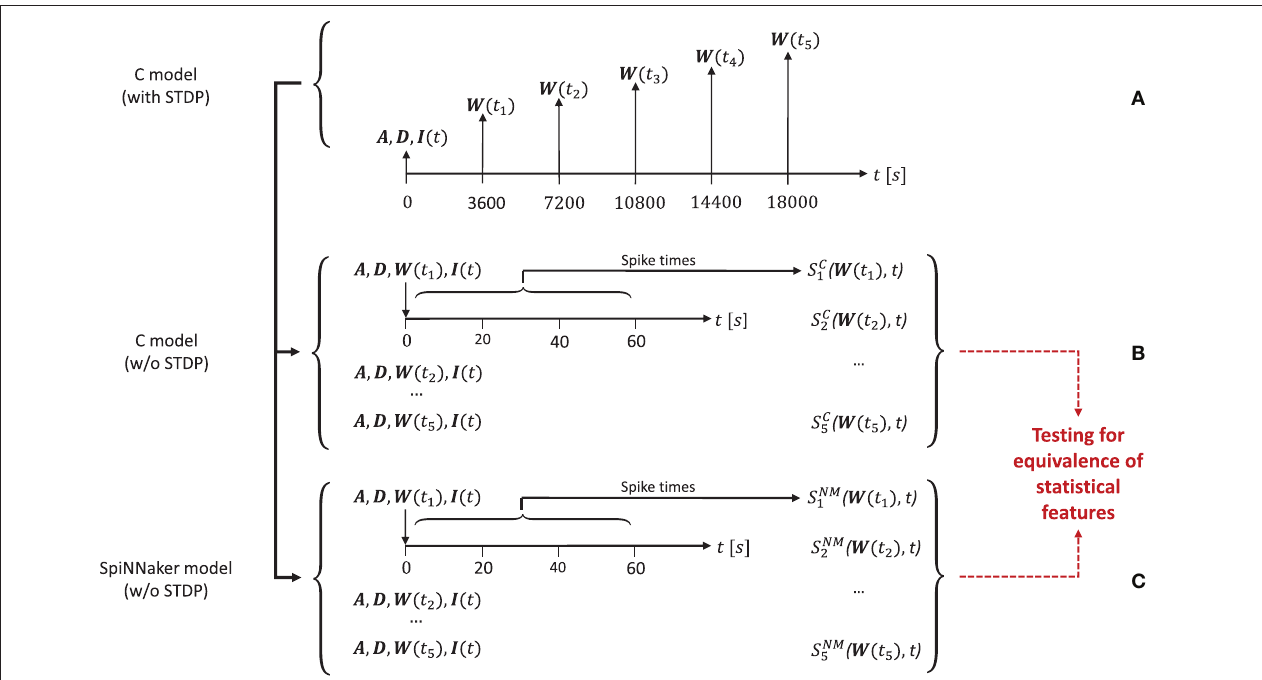
FIGURE 4 | Design of the simulation setup. The time line is annotated by the variables saved or loaded at specific time points of the simulation for the three types of simulations used in the substantiation scenario. (A) Generation of the five initial network states used to simulate data. At the start ( t implementation of the polychronization model (with STDP) the connectivity matrix A and delay matrix D are saved. At the following times t i , the weight matrix W ( t i ) is saved. The random input stimulus to the network I ( t ) is recorded for the duration of the simulation. (B) Generation of data from the five simulations of the C implementation (without STDP) for use in the validation tests based on the random input I ( t ) and the five sets of initial conditions ( A , D , W ( t i )) recorded in (A) , respectively. The network spiking activity S C i ( W ( t i ), t ) is recorded for 60 s. (C) Identical setup as in (B) , but for the SpiNNaker implementation without STDP, where S NM i ( W ( t i ), t ) denotes the simulation result. The data from (B,C) are subject to validation testing based on their statistical features (red dotted lines). Figure amended from Trensch et al.